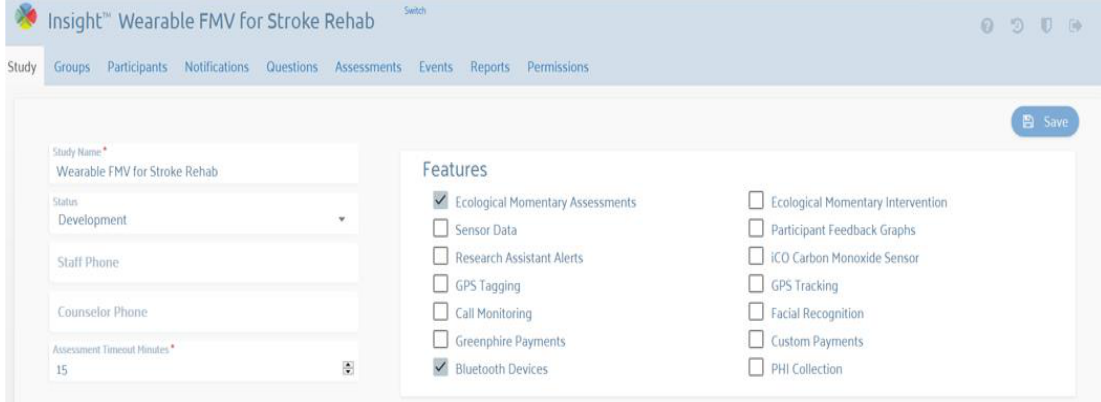
Figure 8. Web portal for the therapist to set up the device for home-based vibration therapy. The therapist can integrate the vibration therapy with feedback surveys after FV therapy and even real-time surveys, e.g., during FV therapy.